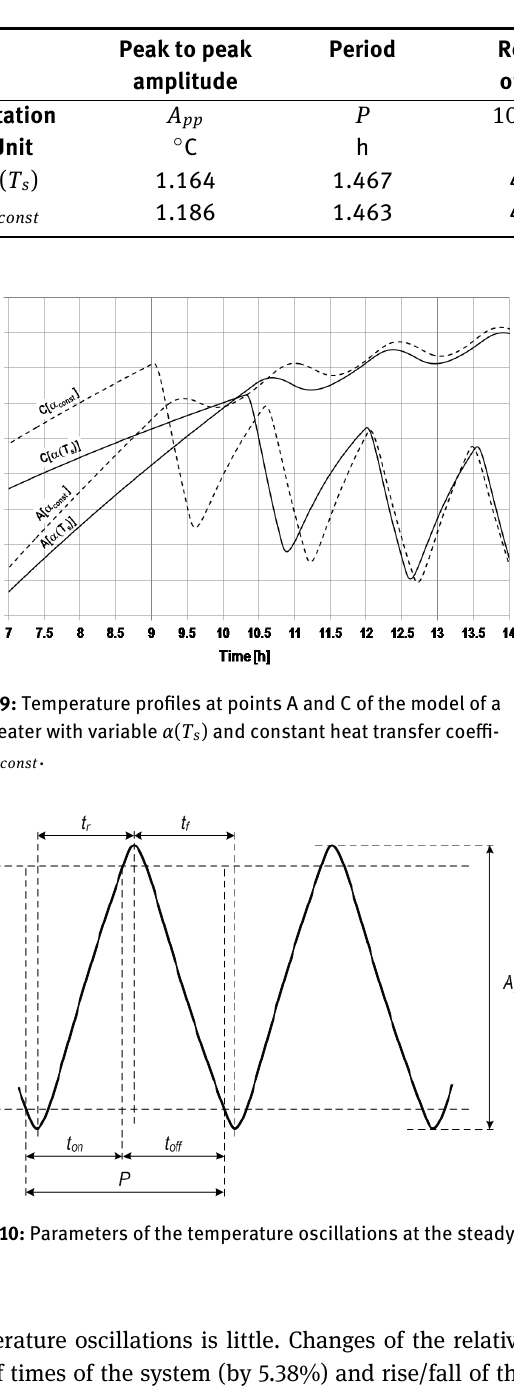
Table 1: Parameters of the steady temperature oscillations at point (B) of the location of a sensor of the regulator.